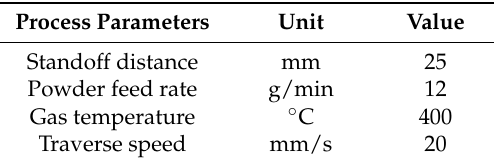
Table 1. LPCS processparameters of spraying powders. Process Parameters Unit